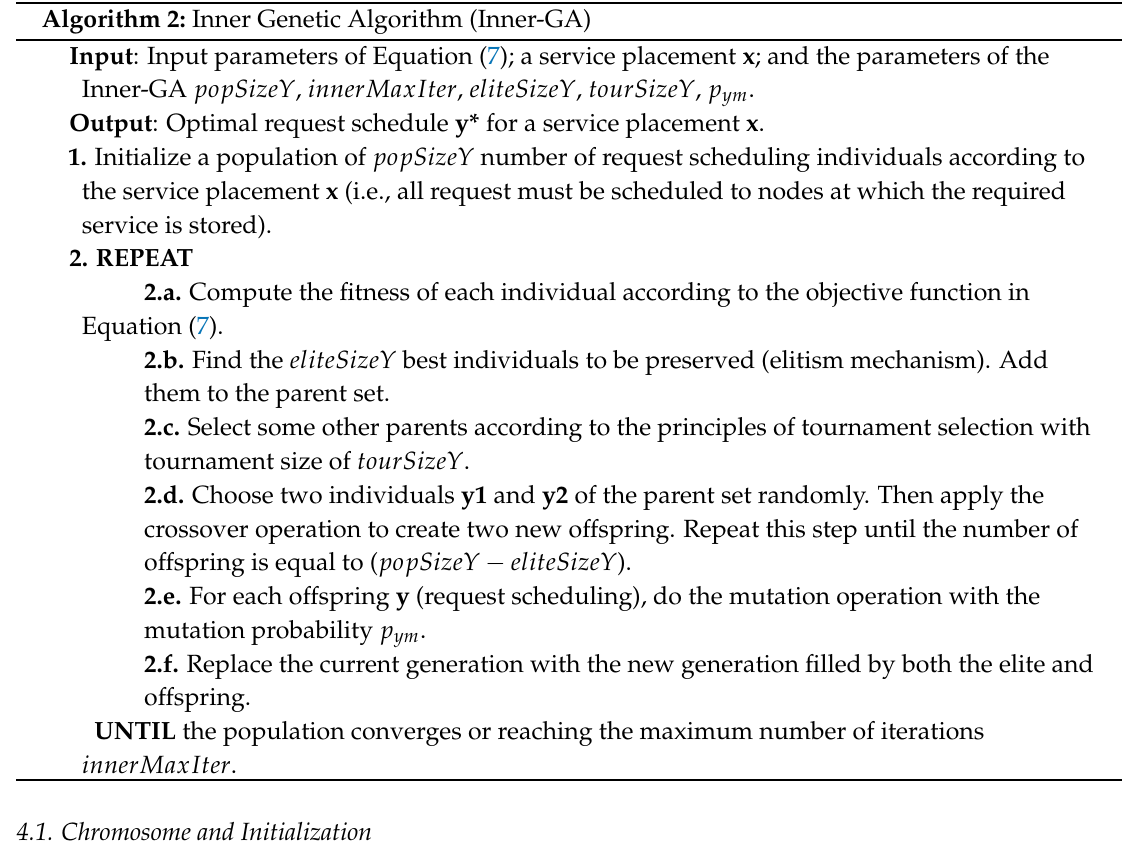
Algorithm 2: Inner Genetic Algorithm (Inner-GA)